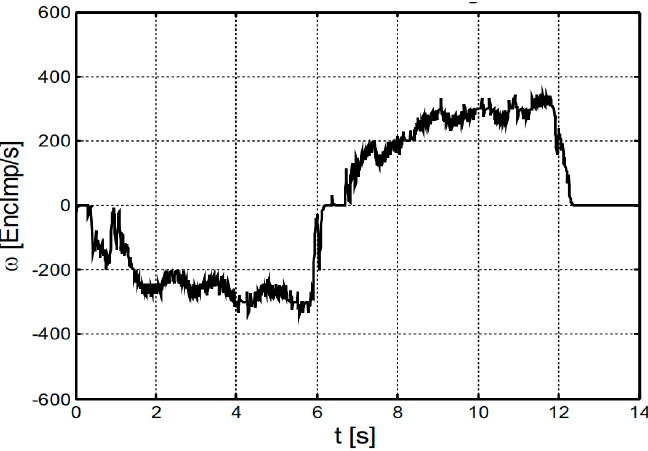
Figure 11. Speed curve when avoiding an